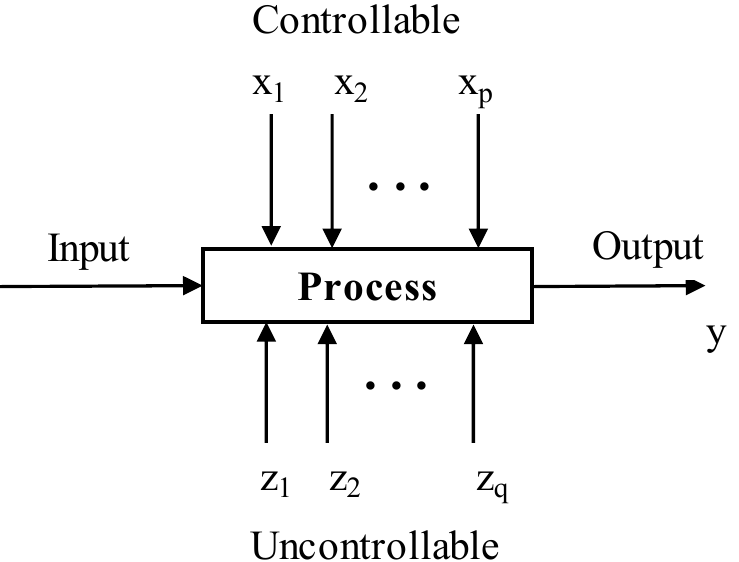
Figure 1. The general model of a process. Table 1. Example of a 2 3 factorial design matrix. Run